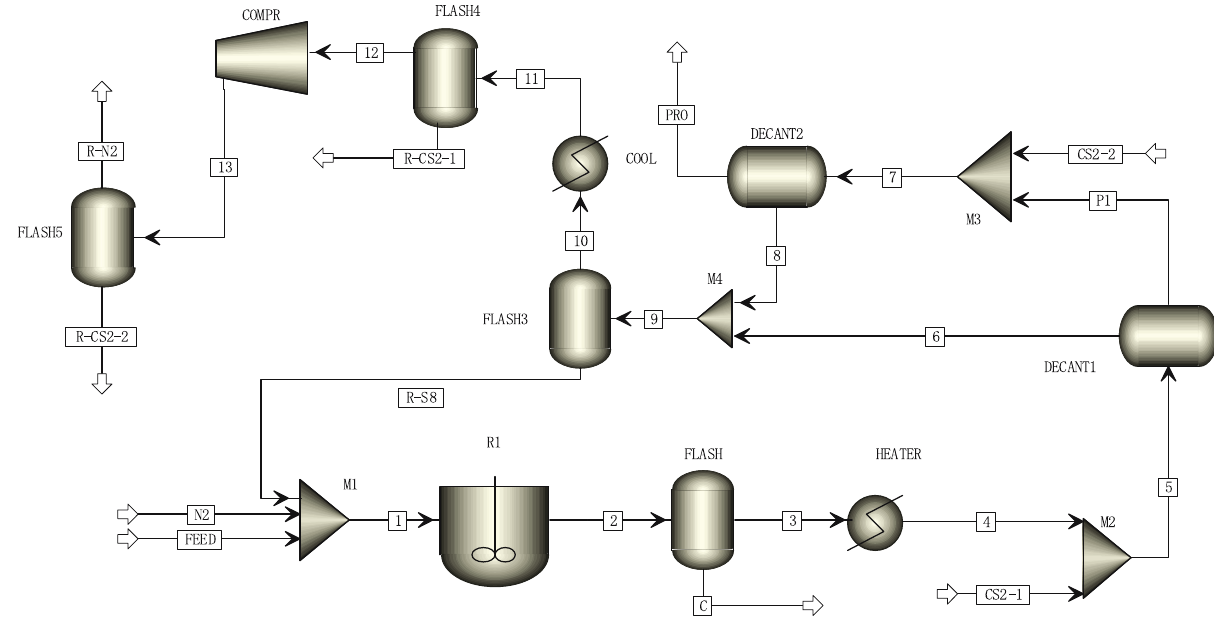
Figure 1: Process fl owchart for IS production in Aspen